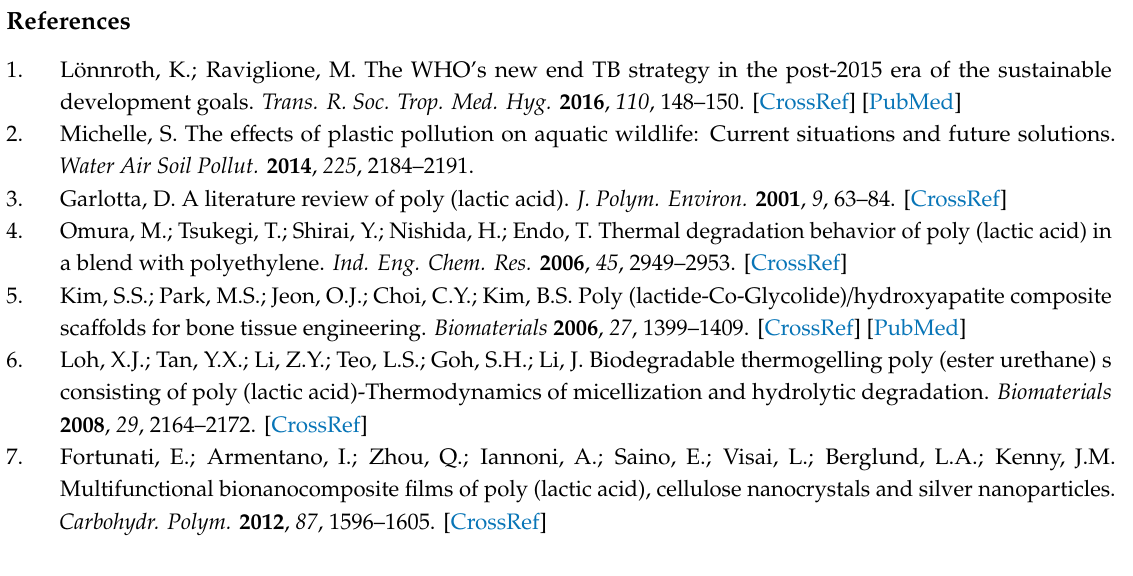
Figure S1: Plots of reciprocal half-time (1 / t 1 / 2 ) of crystallization as a function of cooling rate for pure POM and its blends with PLA, Figure S2: Kissinger plots of ln( ϕ / T p2 ) versus 1 / T p for the non-isothermal crystallization of pure POM and its blends with PLA, Fiture S3: Arrhenius plots of lnK / n versus l / Tc for the isothermal crystallization of pure POM and its blends with PLA, Figure S4: Flynn–Wall plots of ln β versus l / T max for the thermal degradation reaction of POM / PLA blends, Table S1: The thermal degradation temperatures as a function of percentage conversion for pure POM, PLA and POM / PLA blends at di ff erent heating